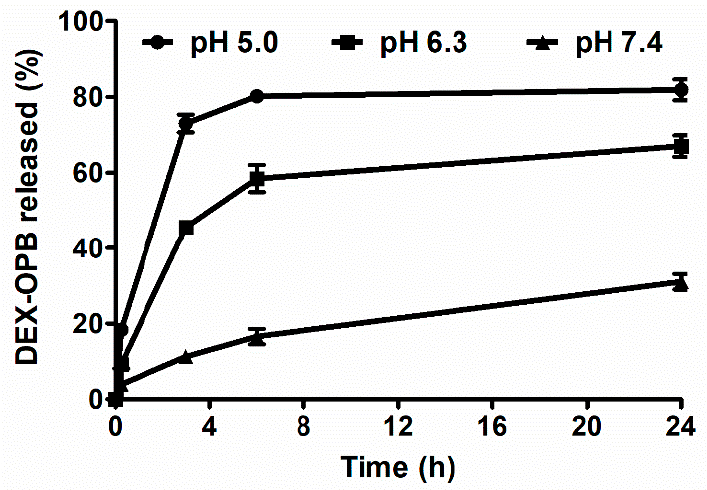
Figure 1. Release of dexamethasone (DEX)-4-(2-oxopropyl)benzoic acid (OPB) at pH = 5.0, pH = 6.3, pH = 7.4.